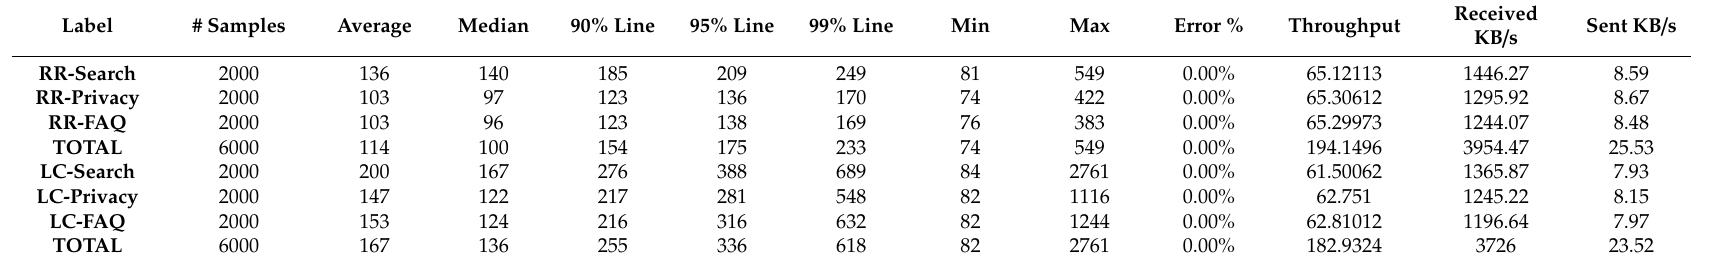
Table 7. Statistics table of the round robin and least connections algorithms for the fourth load